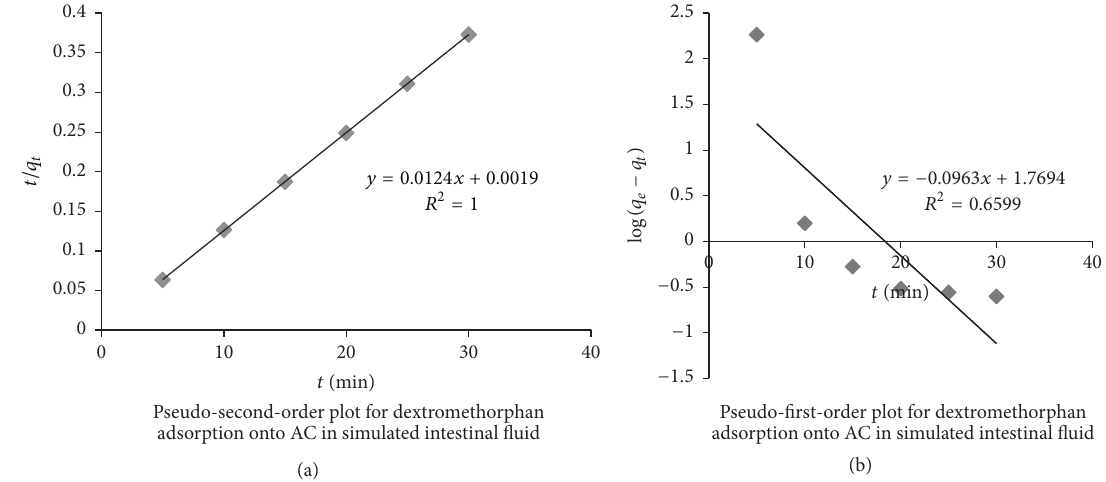
Figure 5: (a) Pseudo-second-order plot for adsorption of DXM on AC in SIF and (b) pseudo-first-order plot for adsorption of DXM on AC in